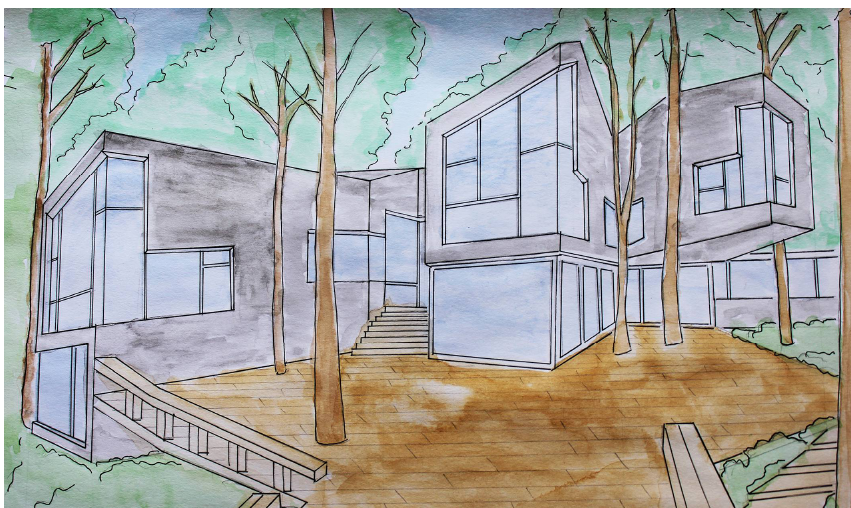
Figure 3. Graphical analysis. Study of Levene House Eduardo Arroyo—San Lorenzo de El Escorial, Madrid (student Marco Ricchiuti).